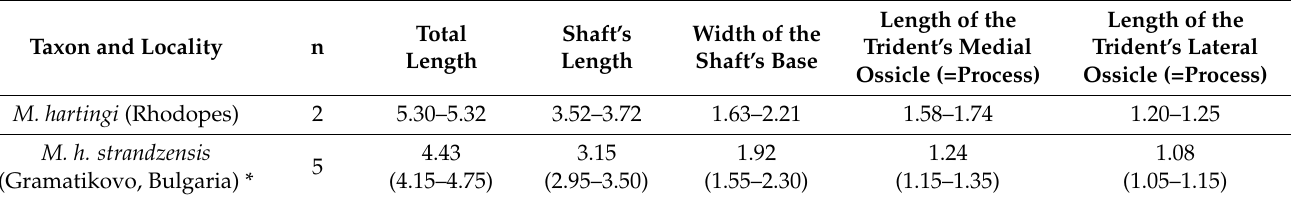
Table 3. Bacular measurements (mm) in M. hartingi . The number of samples (n), range (r), mean